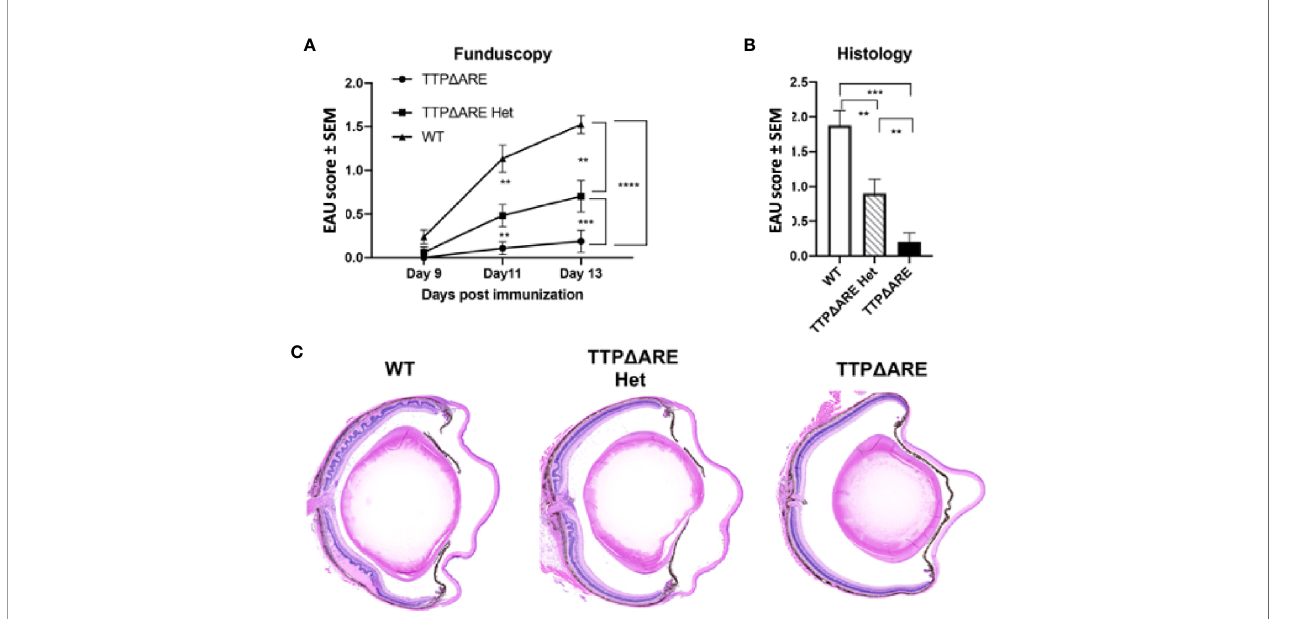
FIGURE 3 | Heterozygous mice develop experimental autoimmune uveitis (EAU) of intermediate severity. Groups of mice from the three genotypes were immunized for EAU induction, and the development of disease was measured by fundoscopy (A) or histology (B) . The fi gure summarizes data from two separate experiments, with fi ve mice in each group. (C) Representative histological sections of eyes of the three mouse genotypes. Mann-Whitney U test was used for statistical comparisons, **p < 0.01, ***p < 0.001, ****p <